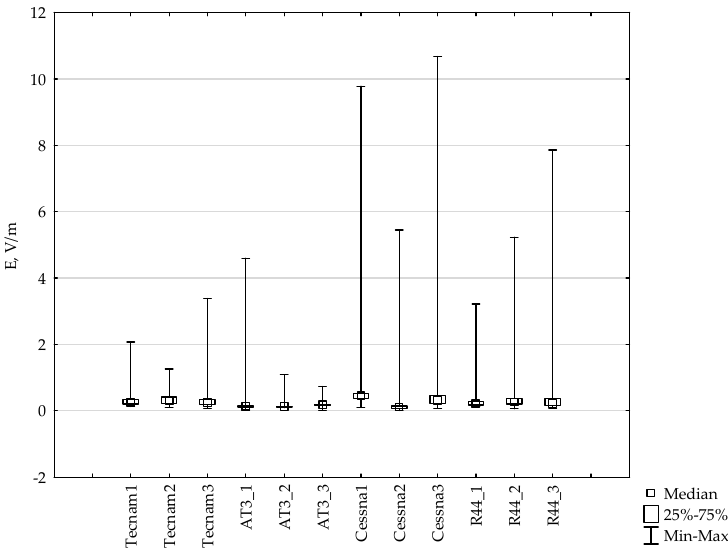
Figure 15. Range of quality and median of electromagnetic (EM) energy during airplane flight. It can be observed that values exceeding the electric field limit occur in selected Cessna 172 and Robinson R44 flights. Figure 16 presents a frame-moustache graph with marked averages and standard deviation.